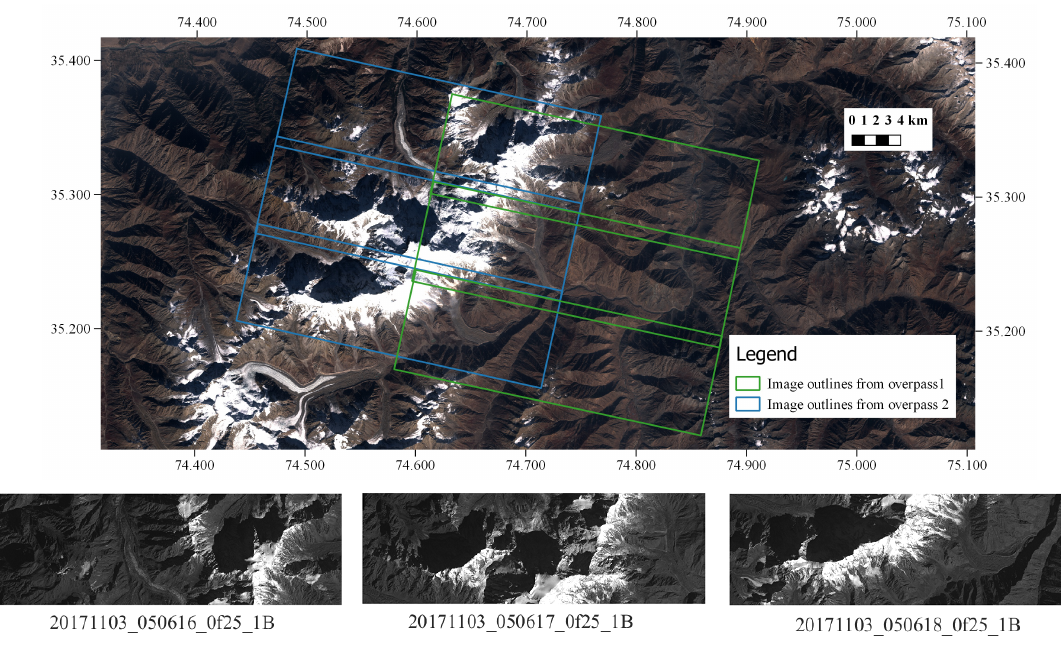
Figure 11. Outlines of the PlanetScope Images from two overpasses over Nanga Parbat displayed over Sentinel Image. Bottom: The NIR band of three PlanetScope images from a single overpass over Nanga Parbat.